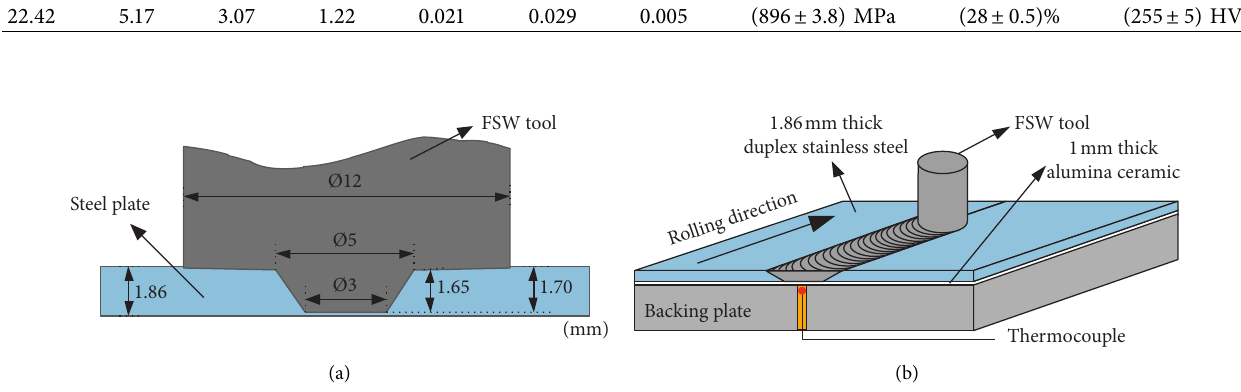
Figure 1: (a) Schematic illustration of the tool geometry and penetration depth. (b) Schematic illustration of experimental configuration for the FSW process.